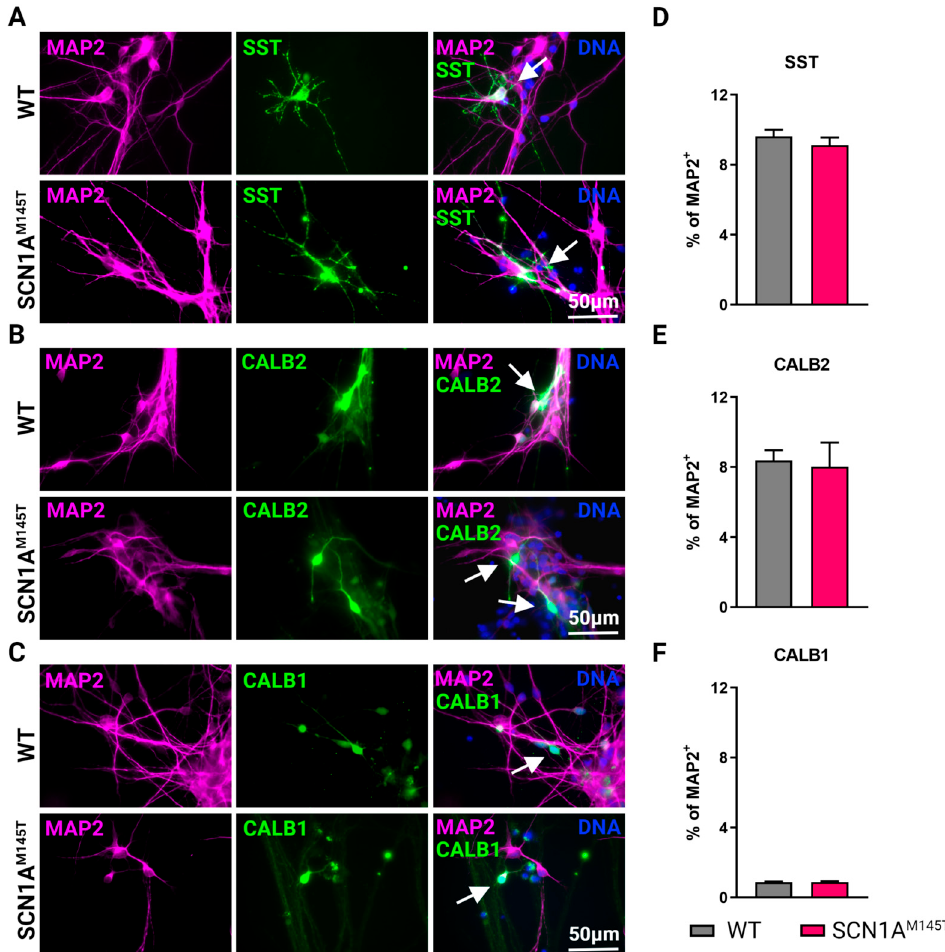
Figure 3. Types of interneurons generated from iPSCs. Immunofluorescence analysis of idNs stained with antibodies against interneuronal subtypes markers ( A ) somatostatin (SST), ( B ) calretinin (CALB2), and ( C ) calbindin (CALB1). In each group of images, WT cells are shown in the upper panel, while SCN1A M145T idNs are shown in the lower panel. White arrows in the merged images indicate neurons expressing the interneuronal makers indicated (63 × magnification). ( D – F ) Quantification of percentage of MAP2 + neurons co-expressing interneuronal markers immunostained in panels ( A – C ). About 9–1% of idNs express SST and CALB2, while CALB1 is present in less than 1% percent of neurons. At least 200 cells were counted for each bar, and data are presented as mean ± SEM of two independent experiments.